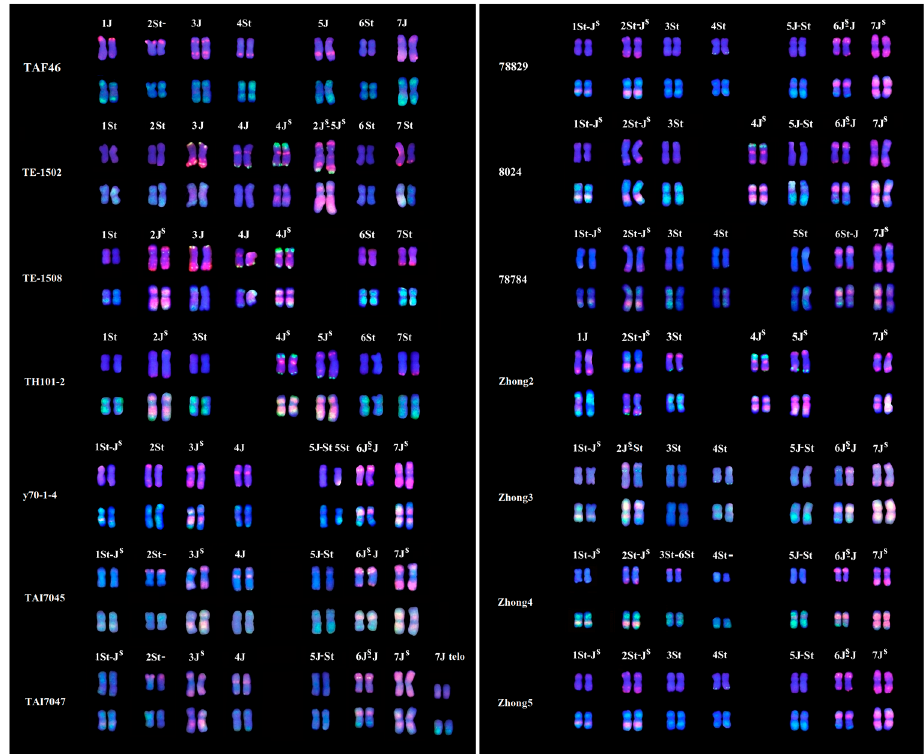
Figure 4. Karyogram of Th. intermedium chromosomes in wheat– Th. intermedium partial amphiploids based on FISH signals of Oligo-pSc119.2 + Oligo-pTa535 (up), and Oligo-B11 + Oligo-pDb12H (bottom). The homoeologous groups 1 to 7 of the Th. intermedium were determined by Oligo-painting probes Synt1 to Synt7. The FISH plates of various partial amphiploids are shown in Table 1 and Figure S2.